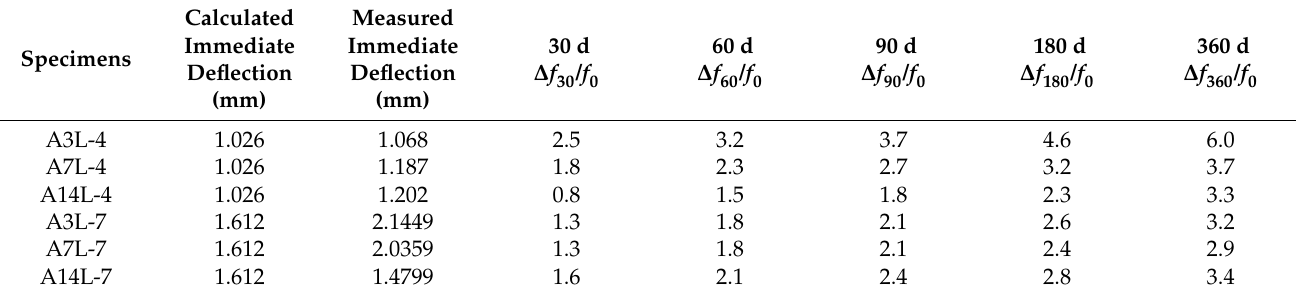
Table 6. Comparison between the theoretical deflection and measured deflections after long-term